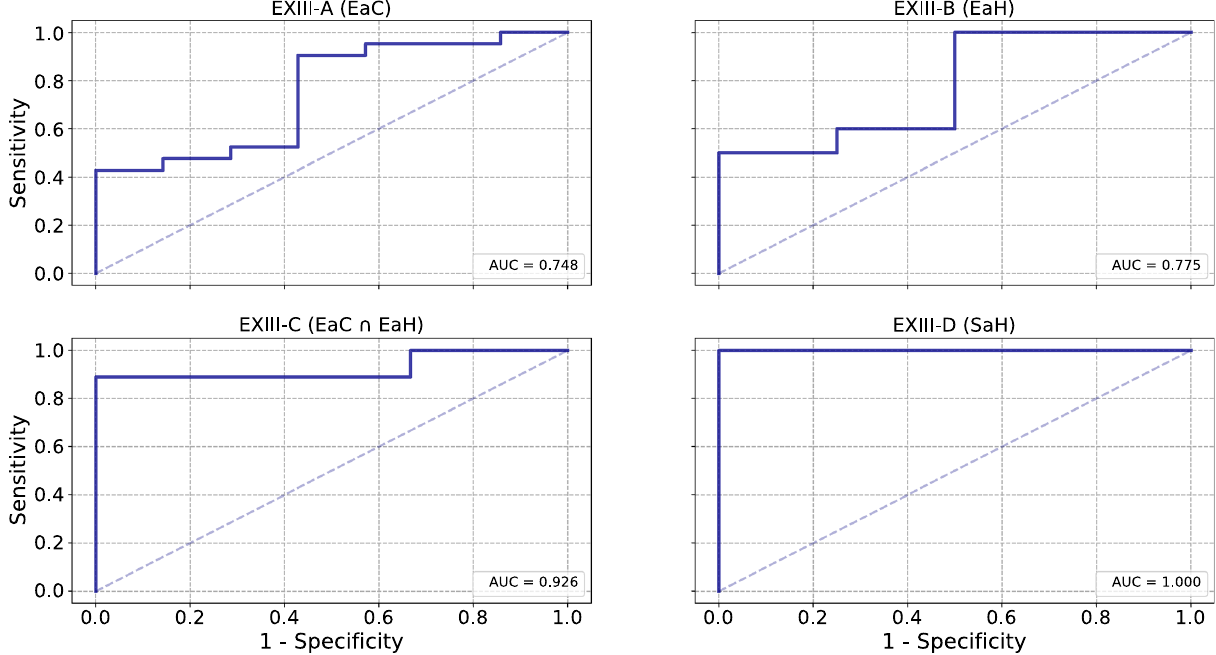
Figure 7. Figure presenting the ROC curves (1-specificity against sensitivity) for the four experiments under EXIII. The obtained AUC metrics are also provided in the bottom right corner of each sub-figure. The presented ROC curves illustrate how well the extracted subject-level PtM indicator can be used to discriminate between the eating behavior of PD patients and HC.